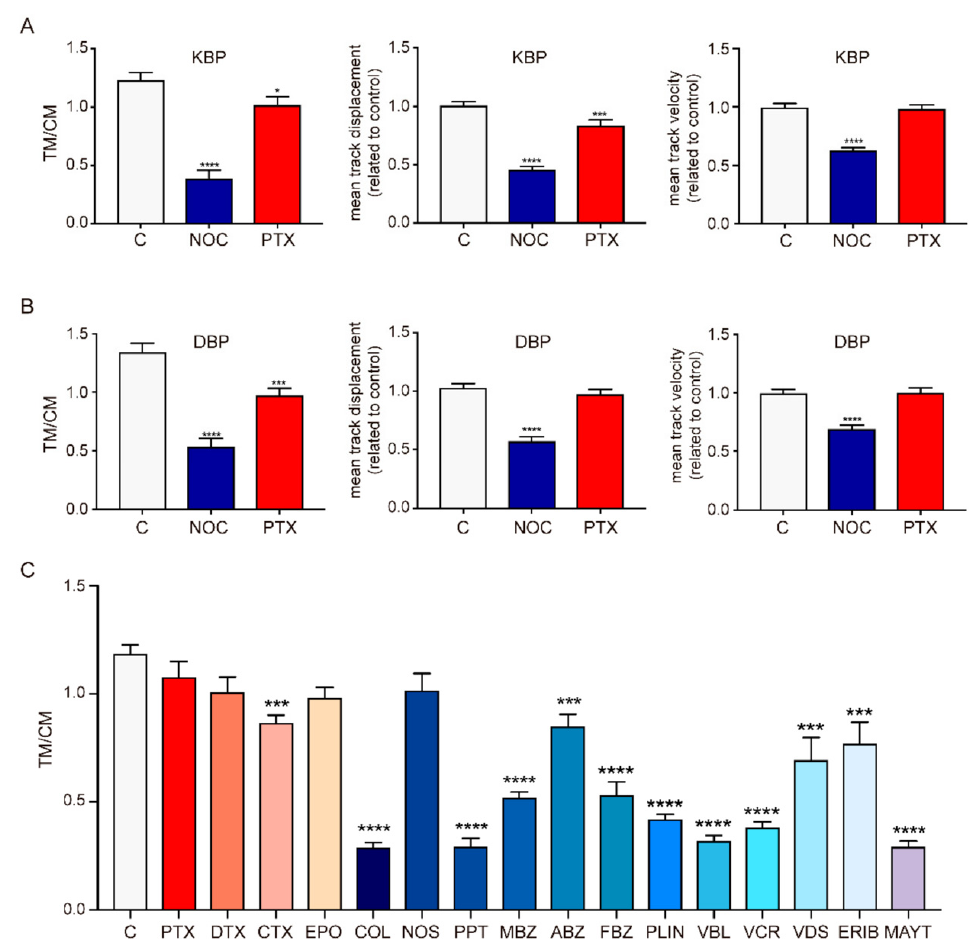
Figure 4. Particle movement parameters measured with KBP ( A ) and DBP ( B ) in the presence of NOC (2.5 µ M) and PTX (10 µ M) in AHRTG cells. TM/CM ( left ), mean track displacement ( center ), and mean track velocity ( right ) analyzed using the TrackMate plugin in ImageJ and the @msdanalyzer in MATLAB. ( C ) KBP TM/CM measured upon pharmacological treatment with clinically available MTAs. Data presented as mean. Error bars indicate S.E.M. from two independent experiments (one-way ANOVA with Bonferroni post-test). Statistically significant differences are indicated by asterisks (**** p < 0.0001, *** p < 0.001, * p < 0.05), n =